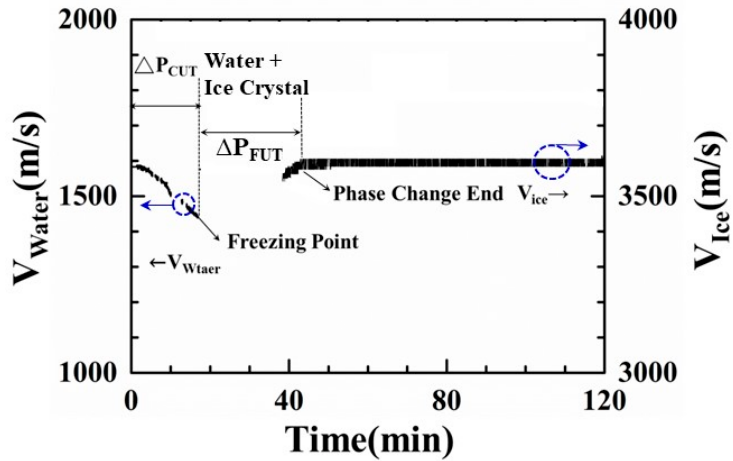
Figure 7. Ultrasonic velocity variation in the water during the freeze-drying process, which indicates the water-in, the freezing point (ice crystallization) and the phase change end.